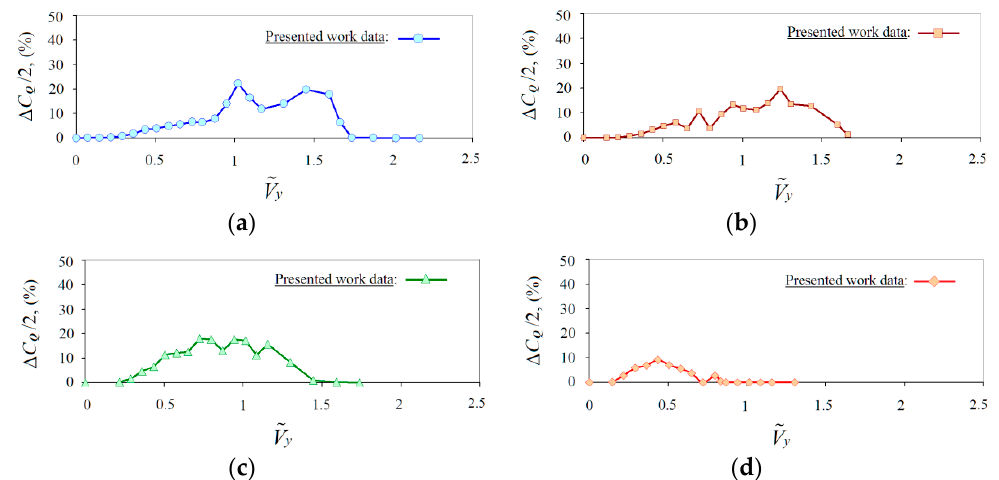
Figure 16. Calculated dependencies of torque pulsation amplitude Δ C Q Σ /2 = f( 𝑉(cid:3560) (cid:3052) ) at α R = 90–30°. ( a ) α R = 90°; ( b ) α R = 70°; ( c ) α R = 50°; ( d ) α R = 30°.